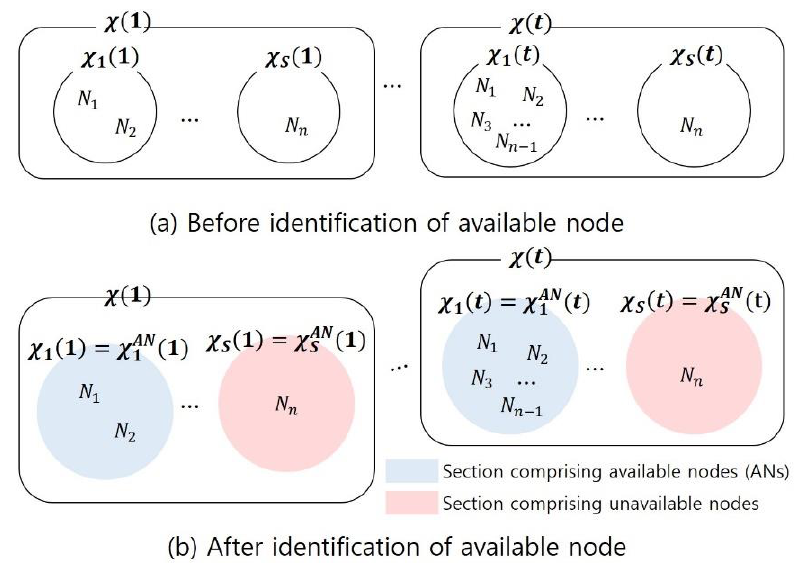
Figure 5. Venn diagrams of nodes of time-varying topologies and sections. Thus, the objective function was applied as expressed in Equation (3) with the con- straints expressed in Equations (4)–(9). The proposed method evaluates the adequacy of the capability (available capacity) by using the peak load for each node and the capacity of each DG [20]. These equations are equally applied to each χ S ( t ) to select the optimal ( t ) containing the χ AN S